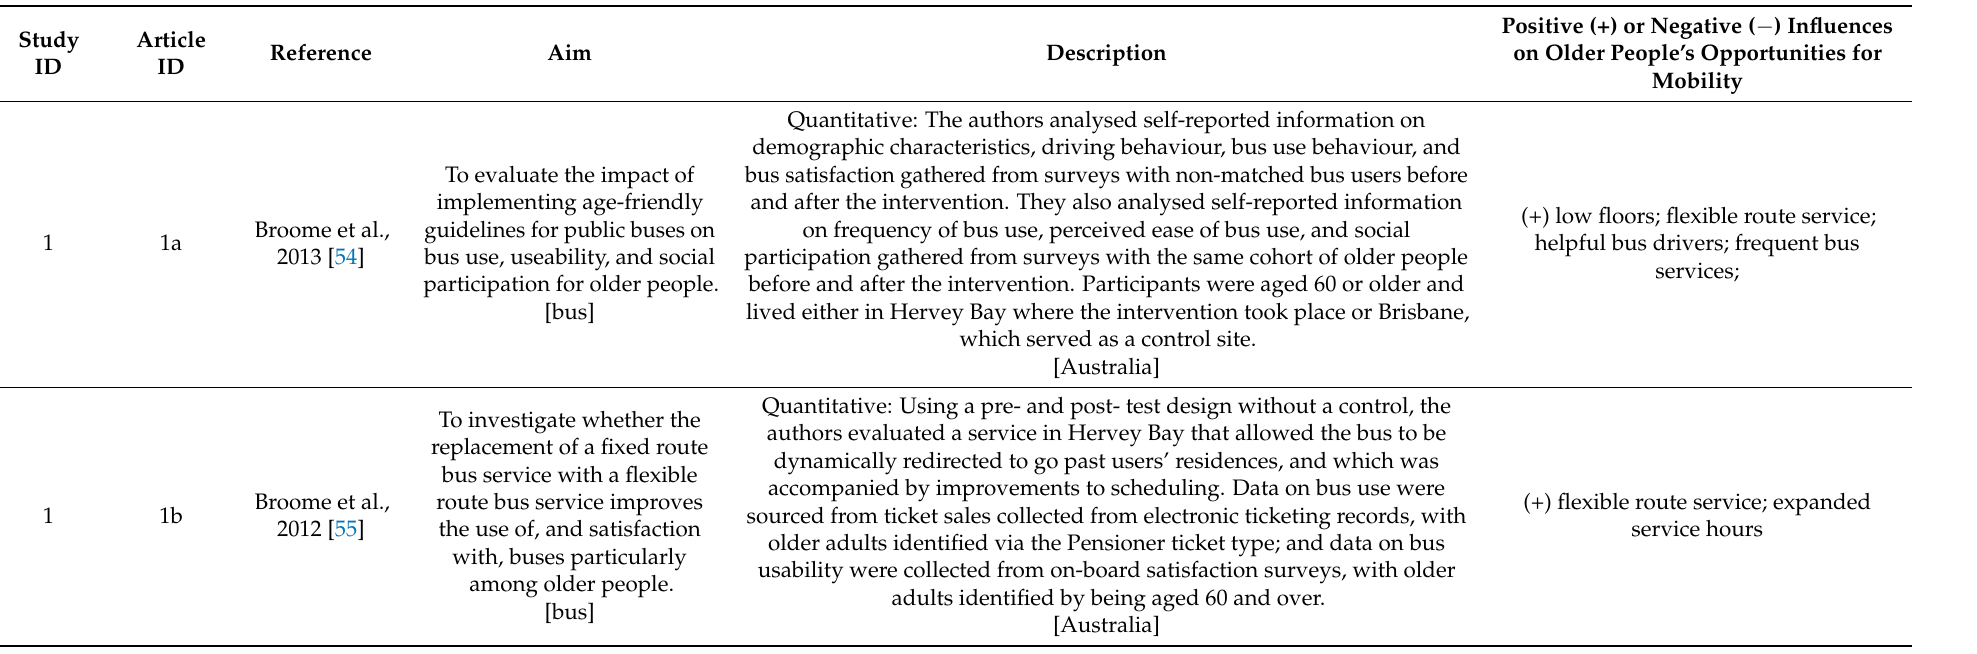
Table 2. Characteristics and findings of included